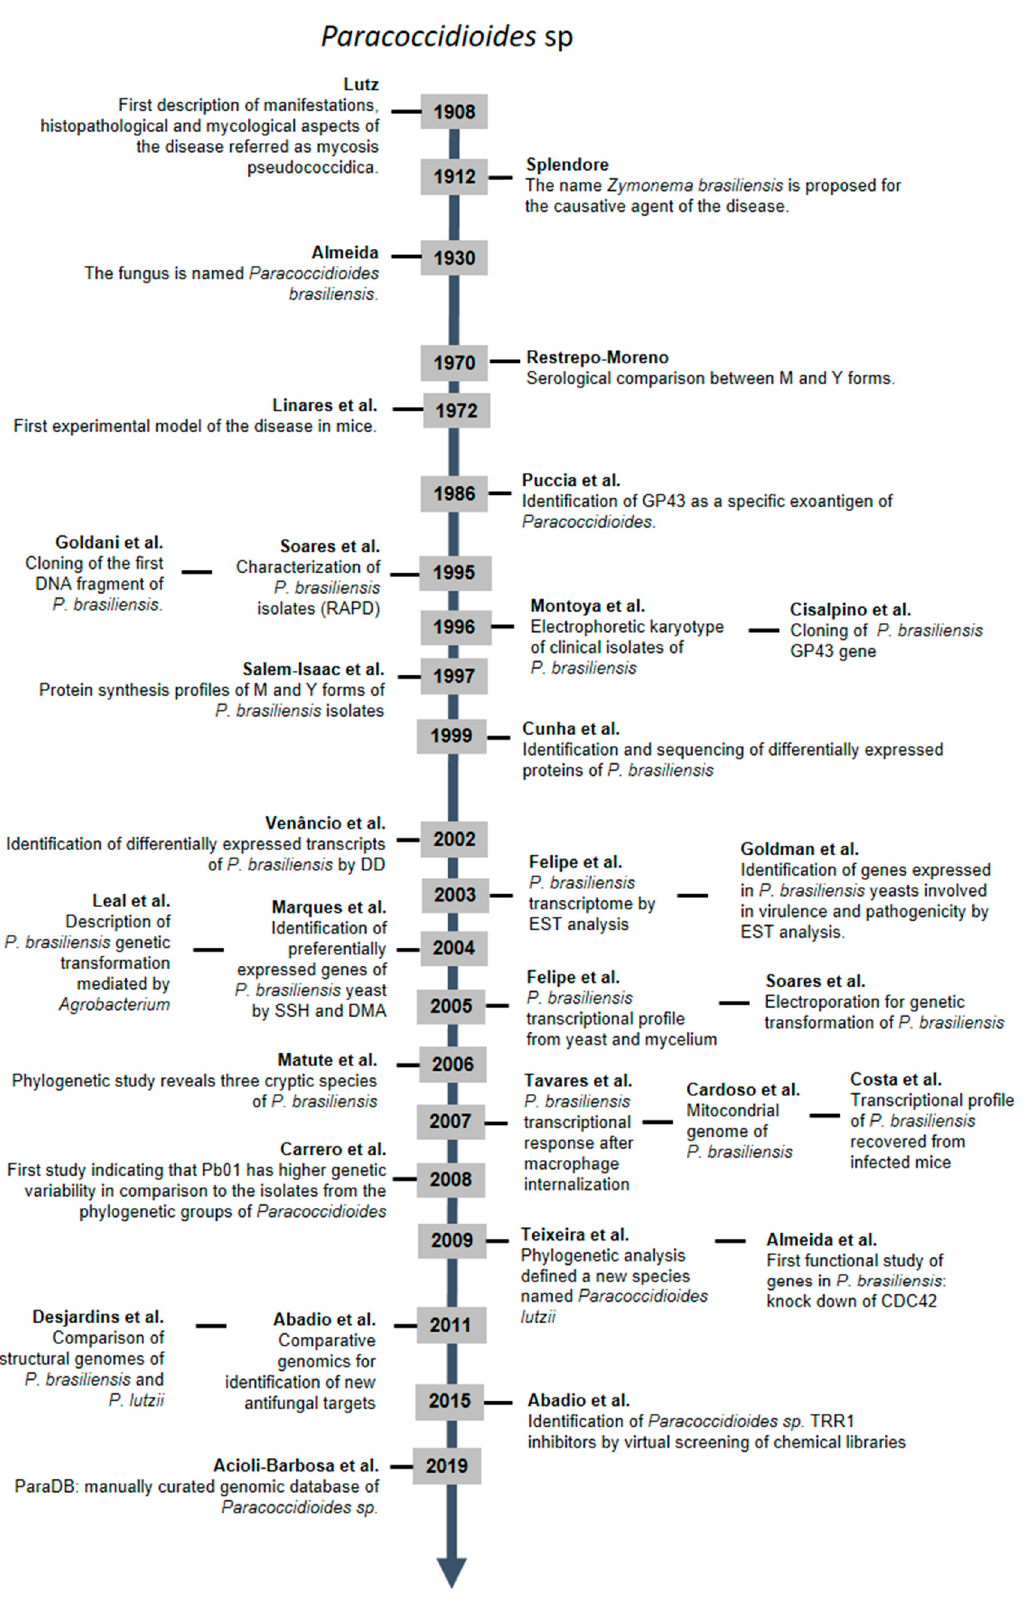
Figure 1. Primary studies related to Paracoccidioides sp. from the first description of the disease to the present day. The timeline herein illustrated for Paracoccidioides findings was based on a Pubmed database using the term “ Paracoccidioides ” as a query.